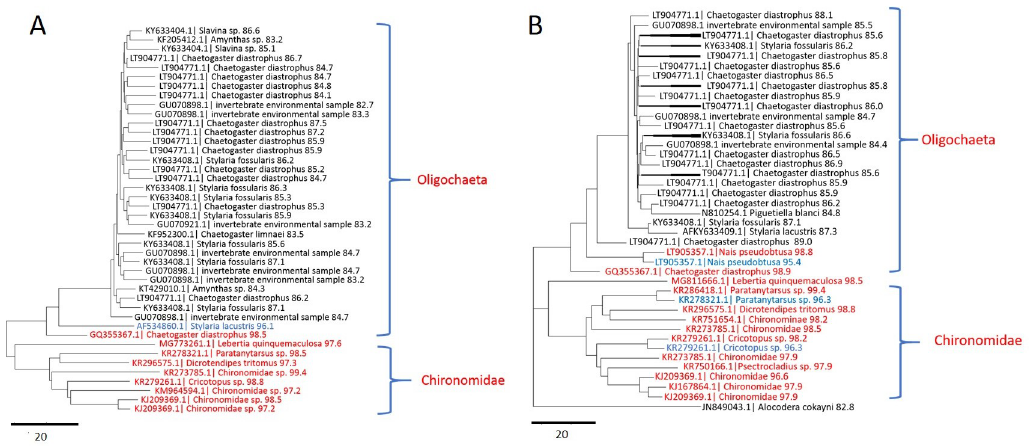
Fig 5. Neighbor-joining tree of non-mite DNA OTUs in representative Lebertia quinquemaculosa mites of PCR products amplified with mLep/LCOI primers-Illumina adapter primers. Each branch is labeled with the “best hit” accession ID in GenBank, taxon name, and the percent identity of the OTU to its best hit. A & B, A mix of oligochaetes and chironomids in specimens of L . quinquemaculosa . Color code: red, identities > 96.5%; blue, identities 90% - 96.5%; black, identities 80% - 90%. All OTUs represent > 4 sequences in A and > 10 sequences in